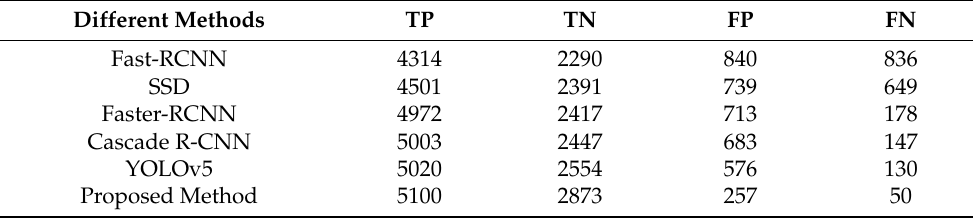
Table 5. Detection results of different